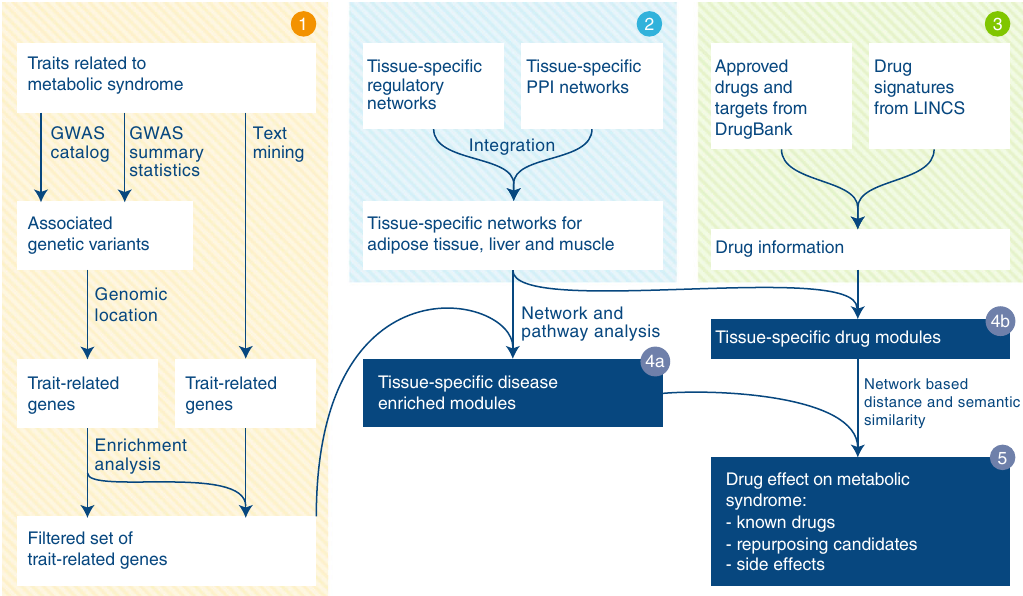
Fig. 1 Schematic illustration of the computational framework. Step 1 MetSyn-related genes are identi fi ed by combining GWAS results and literature fi ndings followed by a fi ltering step based on gene-set enrichment analysis. Step 2 Tissue-speci fi c networks are constructed by integrating transcriptional regulatory networks from 23 and PPI networks from HIPPIE db 25 . Step 3 Drug information is retrieved from DrugBank 29 and LINCS database 11 . Step 4a and b Tissue- speci fi c MetSyn and drug modules are established using network analysis. Step 5 To measure drug effects, a proximity score between drug and MetSyn modules is computed on the basis of network distance and semantic